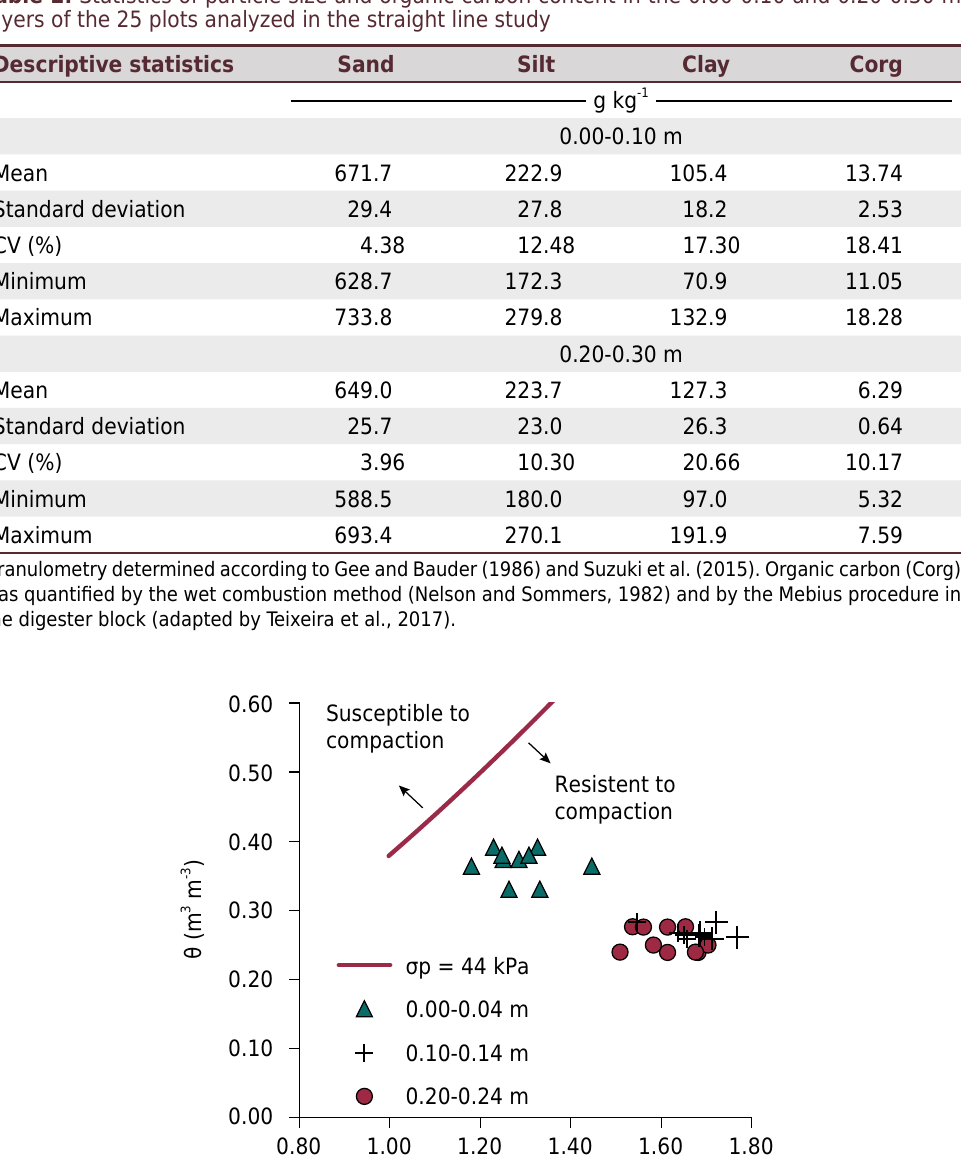
Table 2. Statistics of particle size and organic carbon content in the 0.00-0.10 and 0.20-0.30 m layers of the 25 plots analyzed in the straight line study